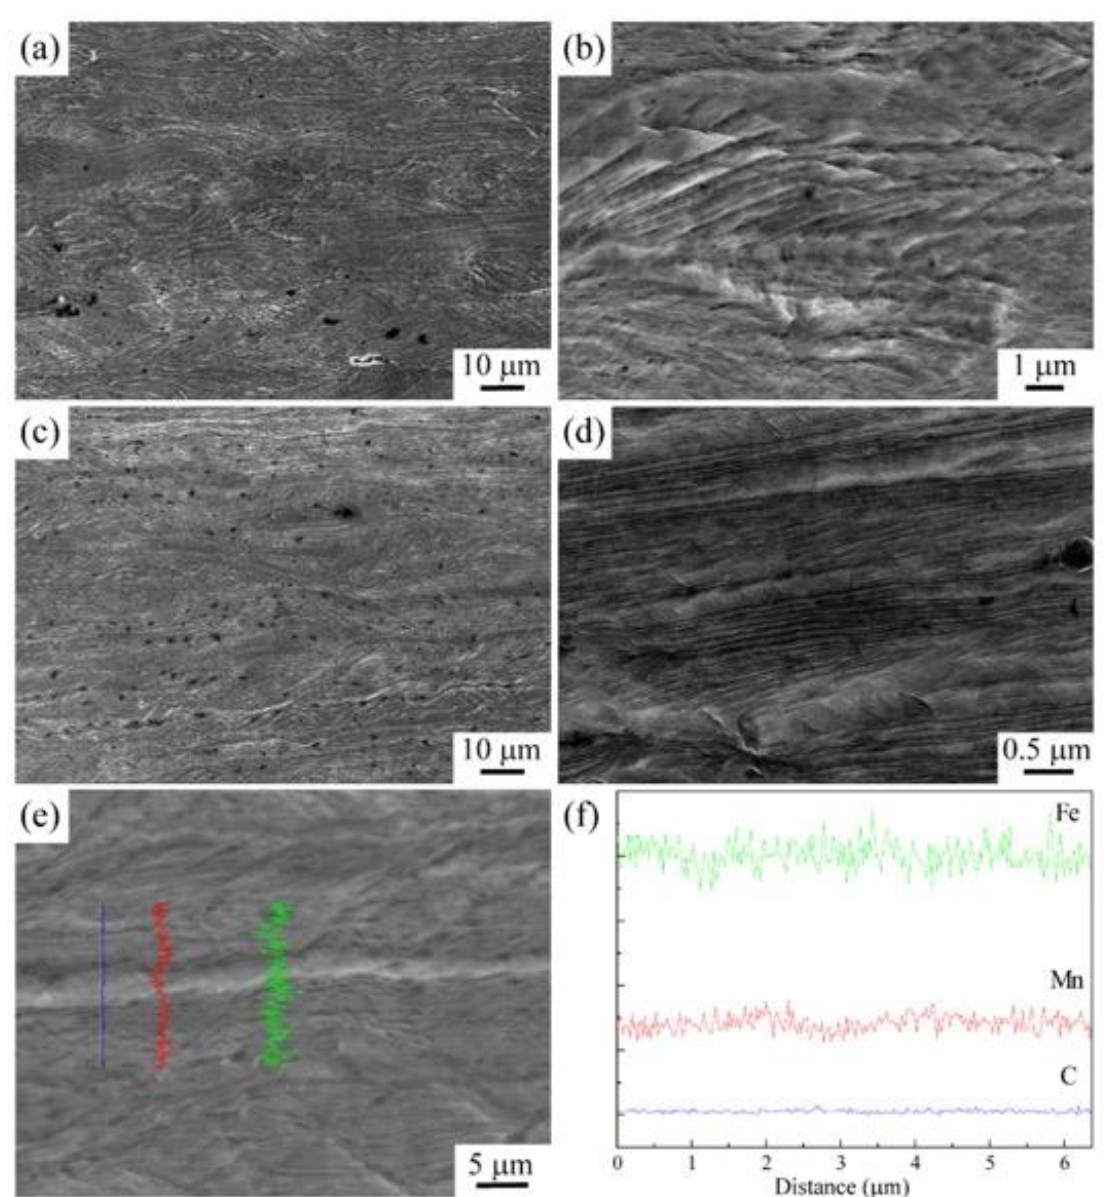
Figure 4. SEM with different magnifications of TWIP steel at various CR deformation levels: ( a,b ) 50% and ( c,d ) for 75%. EDS line profiles of 75% CR deformation for TWIP steel: ( e,f ).